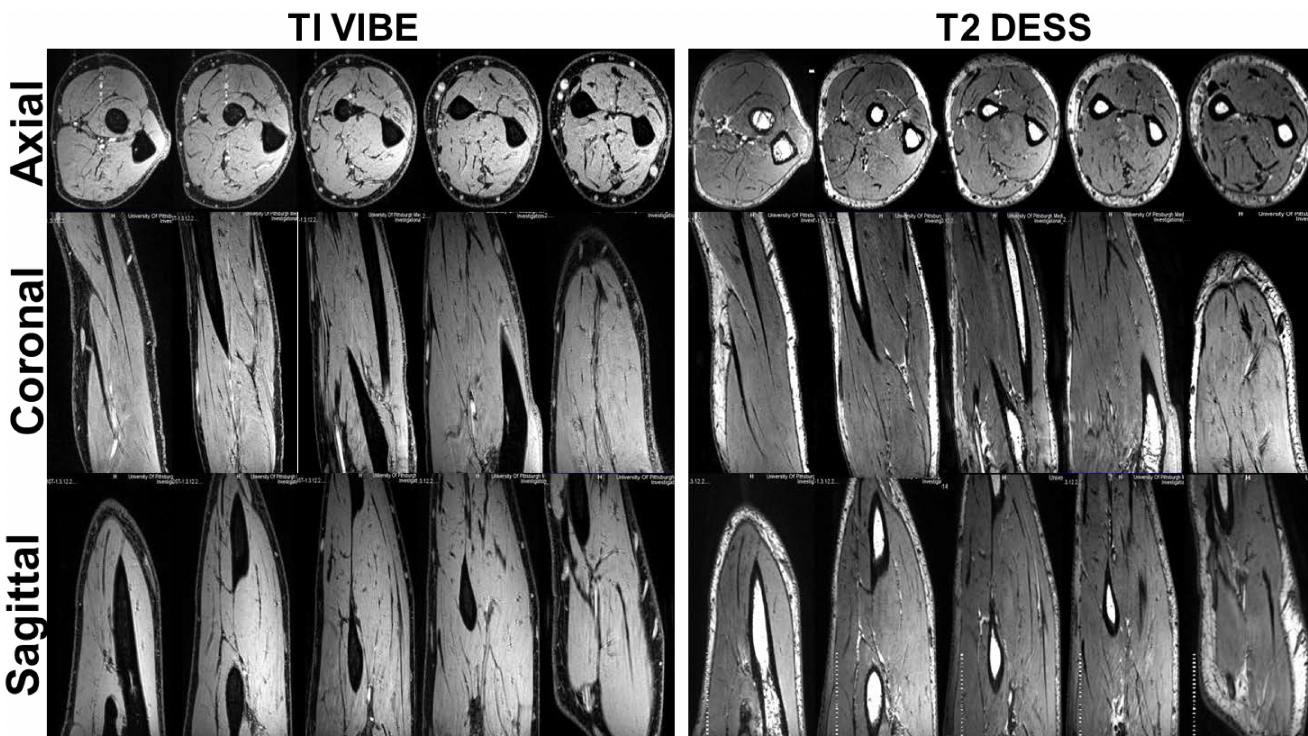
Fig 3. 7T T1 VIBE and T2 DESS images of the forearm demonstrating homogeneous excitationin axial [elbow to wrist], coronal and sagittal planes. The B1+ field coefficient of variation was calculatedto be 21% in the forearm [encapsulated within the coil volume].